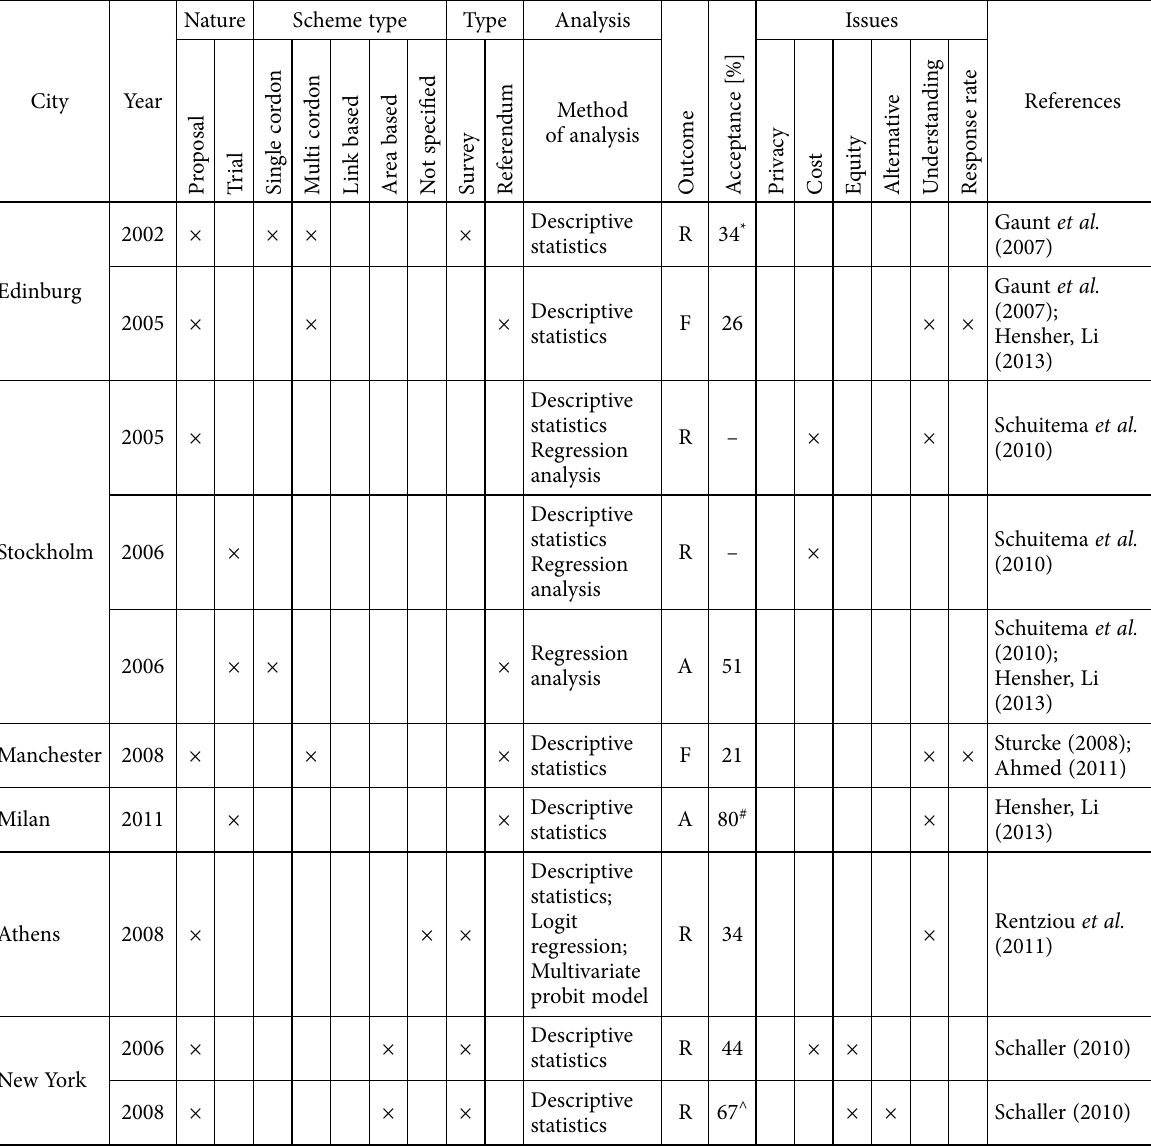
Table 1. Surveys on the public acceptance of